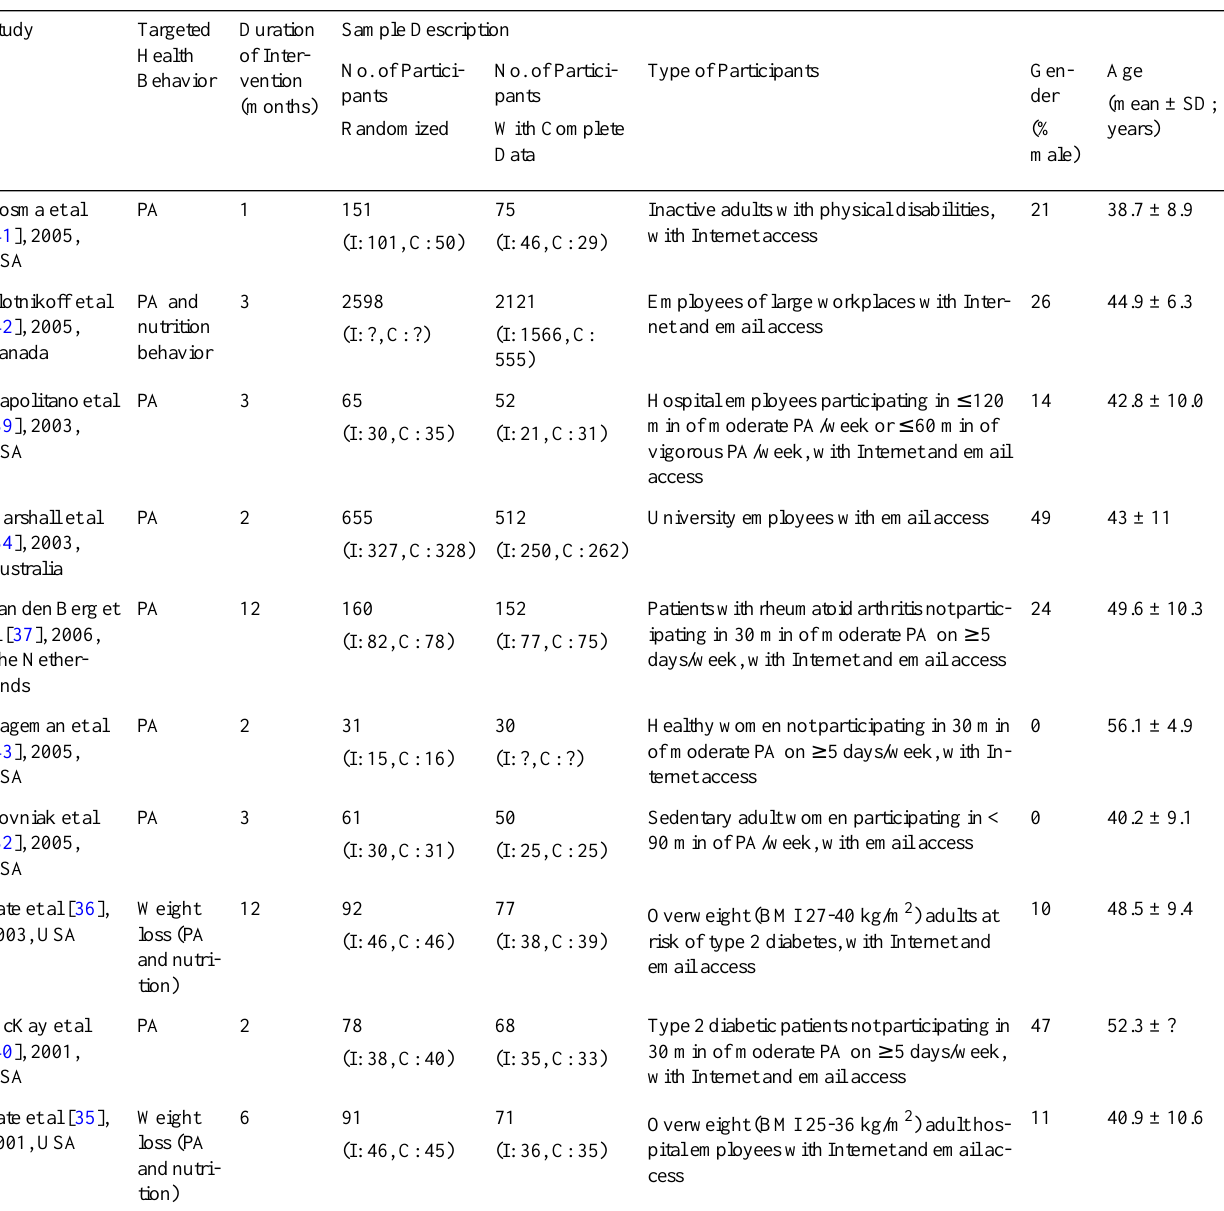
Table 3. Characteristics of studies and participants*